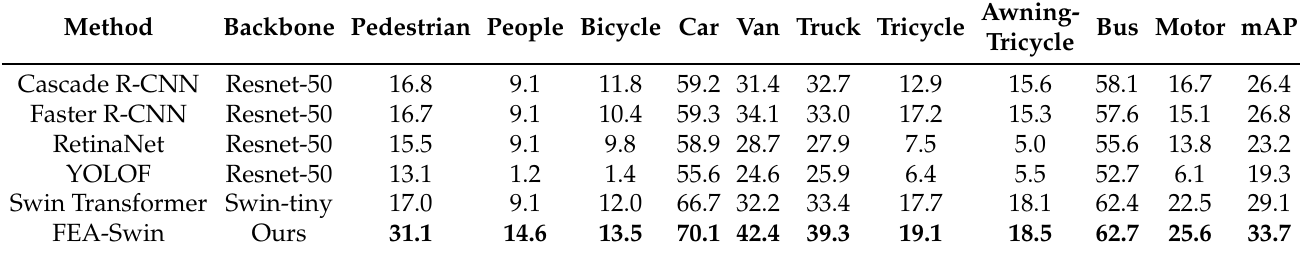
Table 1. Comparison results on VisDrone2021-DET-test-dev. The bolded numbers are the best indicators for each